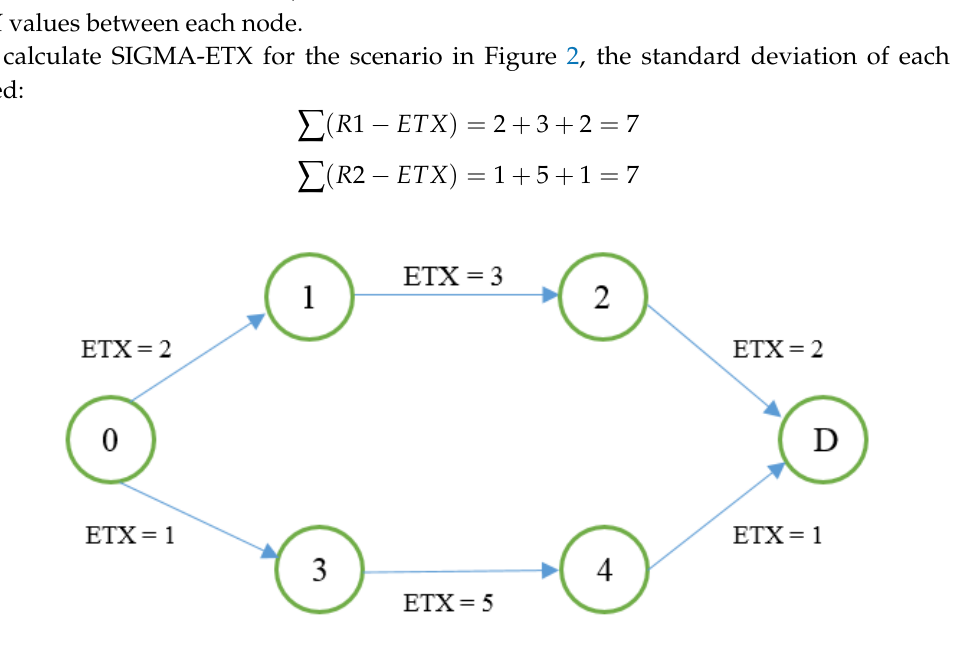
Figure 2. Example of tie between ETX averages .